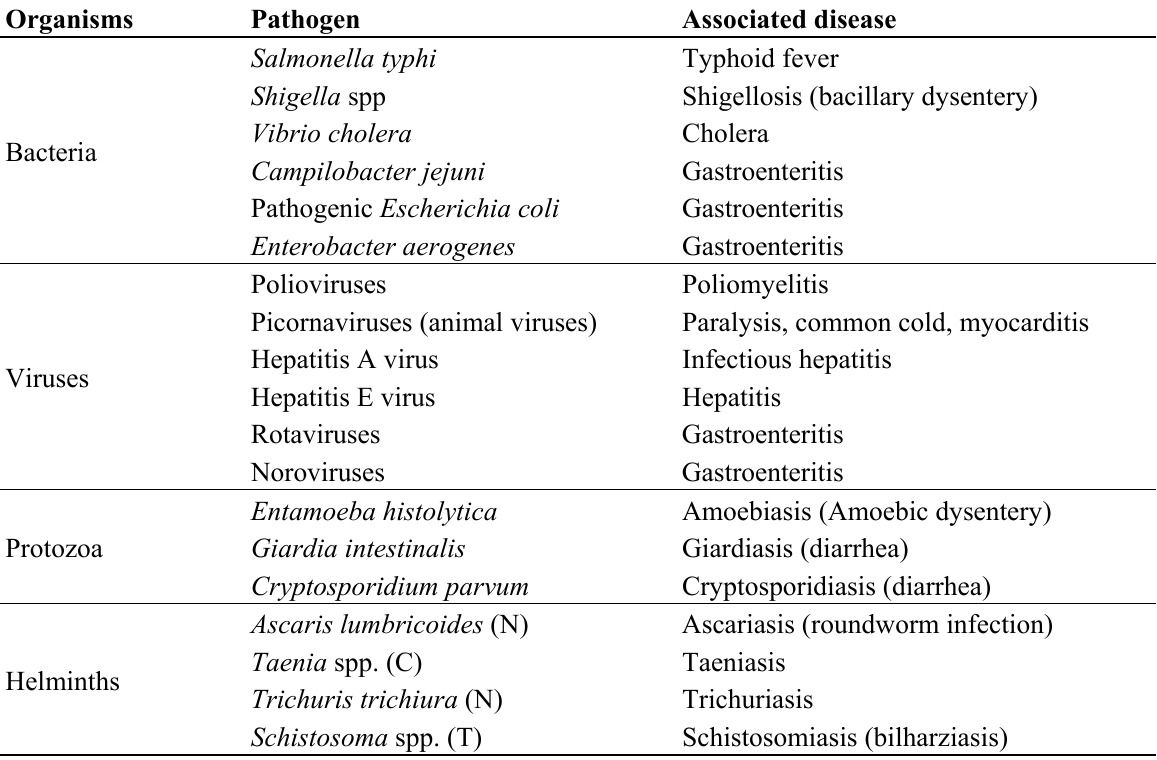
Table 4. Main pathogens potentially present in wastewater and associated